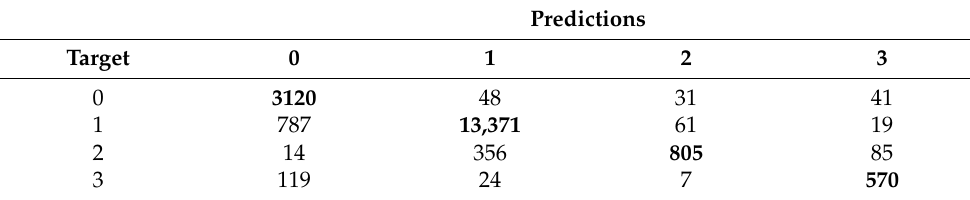
Table 3. Confusion matrix for the support vector machine-based